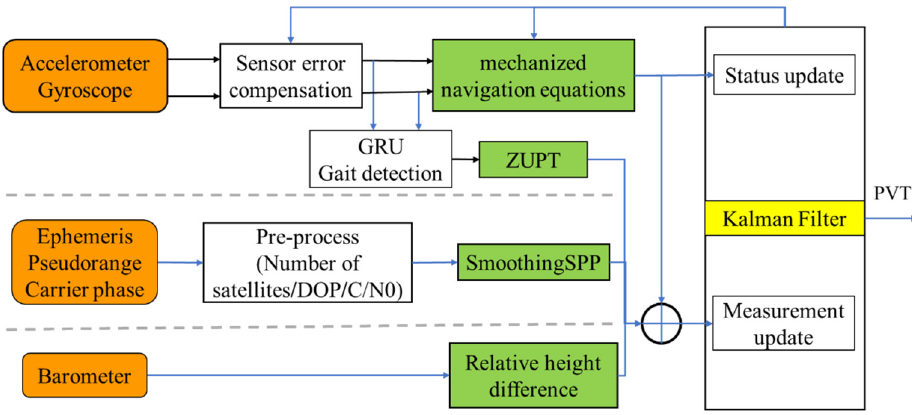
Figure 1. The data fusion strategy flowchart.